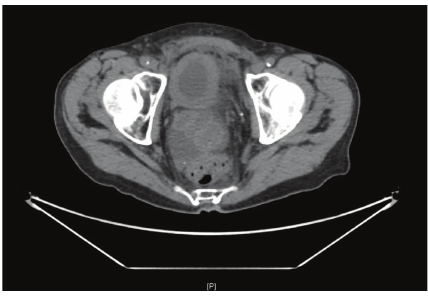
Figure 1: Pelvic CT showing di ff uesly thickened bladder wall.